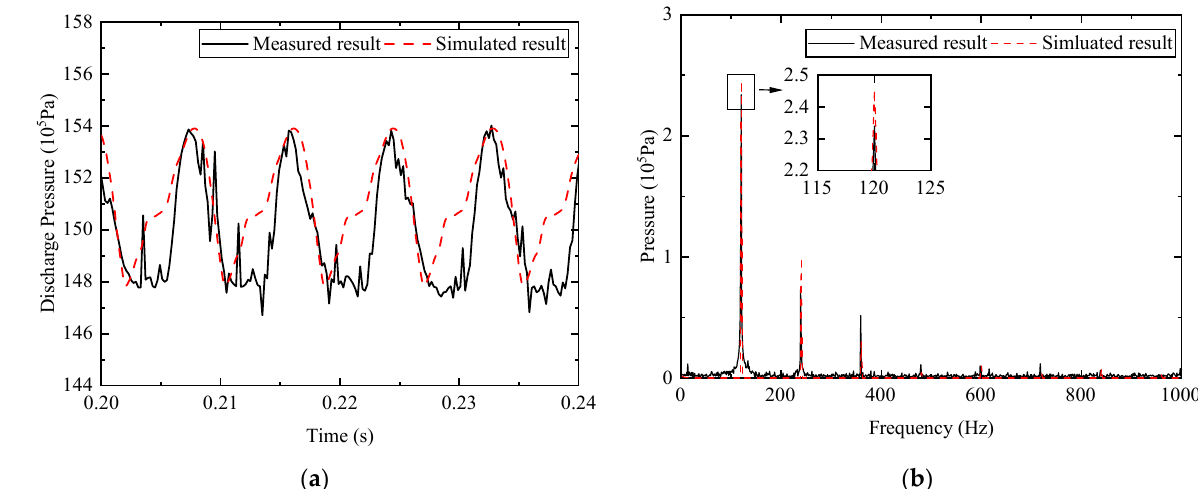
Figure 4. Comparison of the discharge pressure: ( a ) time domain; ( b ) frequency domain.